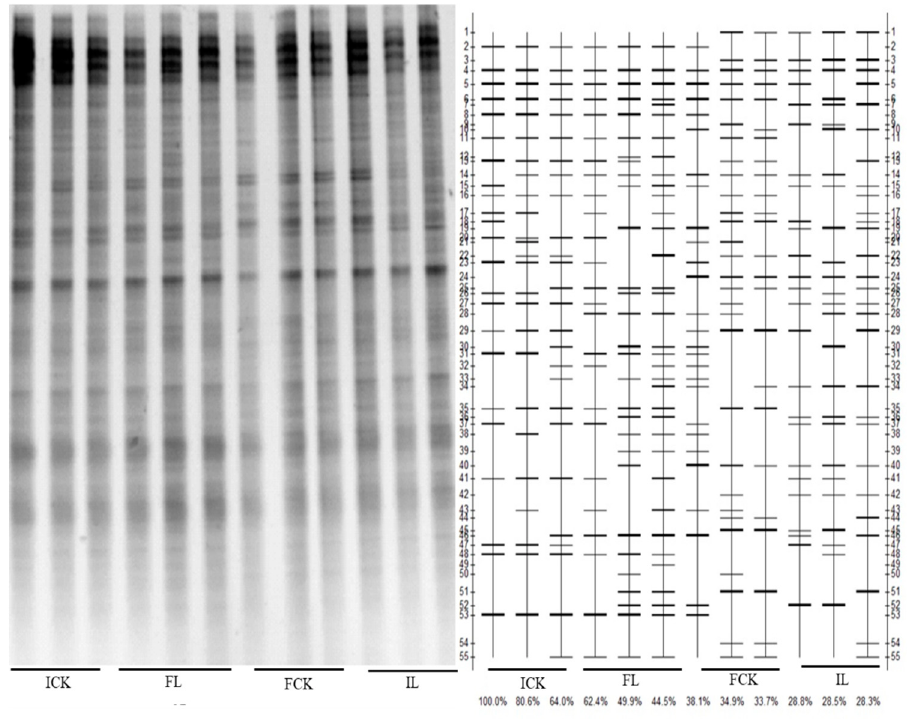
Figure 3. Denaturing gradient gel electrophoresis (DGGE) profile of rhizosphere bacteria communities in contaminated soils.